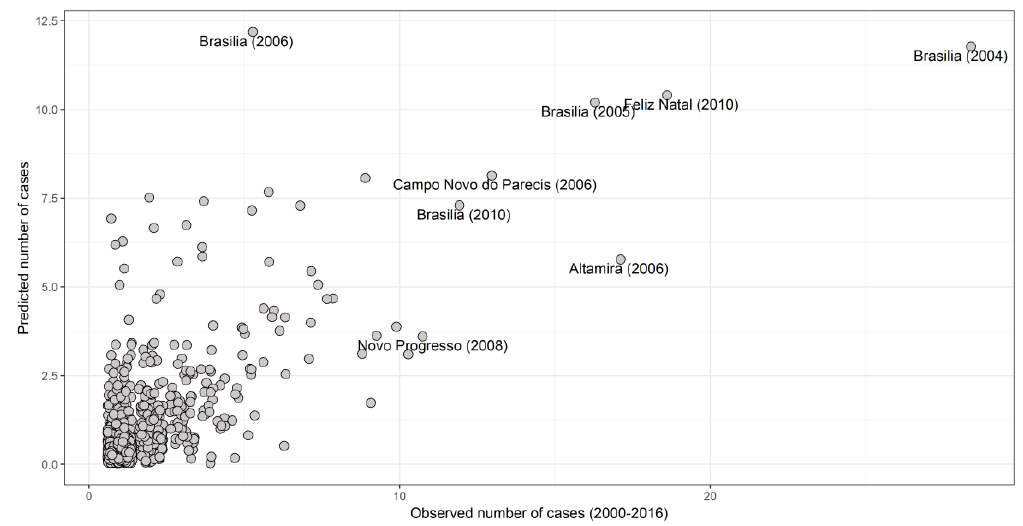
Figure 3. Distribution of potential hantavirus hosts in Brazil: ( a ) Richness of potential hantavirus hosts in Brazil. Lighter colors represent more hosts. The grey areas represent variation in pixel counts per latitude and longitude. ( b ) Binary maps generated by Ecological Niche models with the black areas indicating higher habitat suitability for each modeled rodent species.